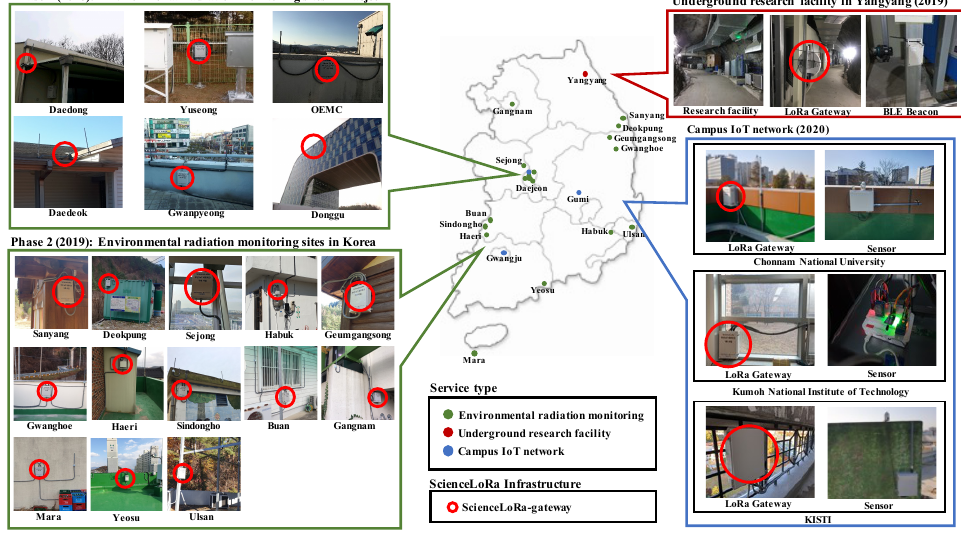
Figure 9. ScienceLoRa Service and system